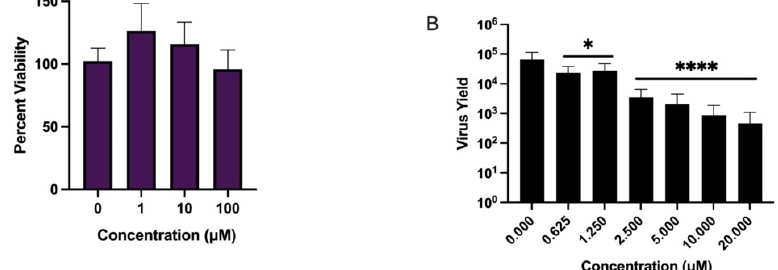
Figure 5. Cytotoxicity and anti-YFV activity of C9 in primary human macrophages. Monocytes were isolated from human blood (pooled from three donors), plated at 10 5 cells per well in a 96-well plate, and treated with GM-CSF for 10 days. ( A ) MTS reduction assay. MDMs were treated with increasing amounts of compound (0–100 µ M), left untreated (positive control), or treated with 0–10 µ M of cycloheximide (experimental control) for 4 days. After 4 days, cultures were assayed for viability via ability to reduce MTS over 4 h. Reduction in viability was determined by one-way ANOVA with Dunnet’s correction for multiple comparisons in GraphPad Prism v9. Data shown as mean ± SEM, n = 6. ( B ) Antiviral activity of C9 in YFV-infected MDM cultures. Cells were treated with 0–10 µ M of C9 and infected with YFV MOI 1.0 for 3 days. At 72 hpi, supernatants were collected, total RNA isolated, and YFV genome copies detected by qPCR. Relative genome copy numbers were correlated to total virus yield via a standard curve. EC 50 and EC 90 values were calculated by linear regression and the significance of reduction by one-way ANOVA with Dunnet’s correction for multiple comparisons in GraphPad Prism v9. Data shown as mean ± SEM, n = 8. p